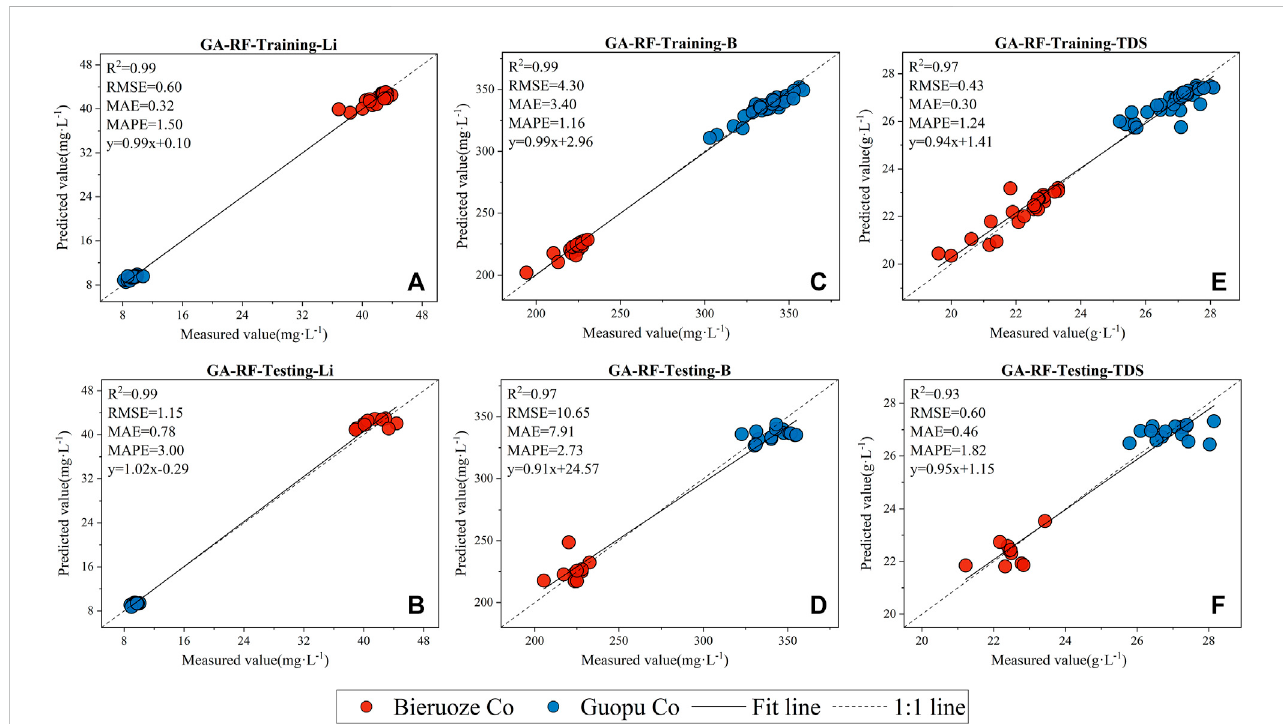
FIGURE 7 Fitting of measured and predicted values using GA-RF models. Estimated Li content based on the training (A) and testing (B) . Estimated B content based on the training (C) and testing (D) . Estimated TDS content based on the training (E) and testing (F) .